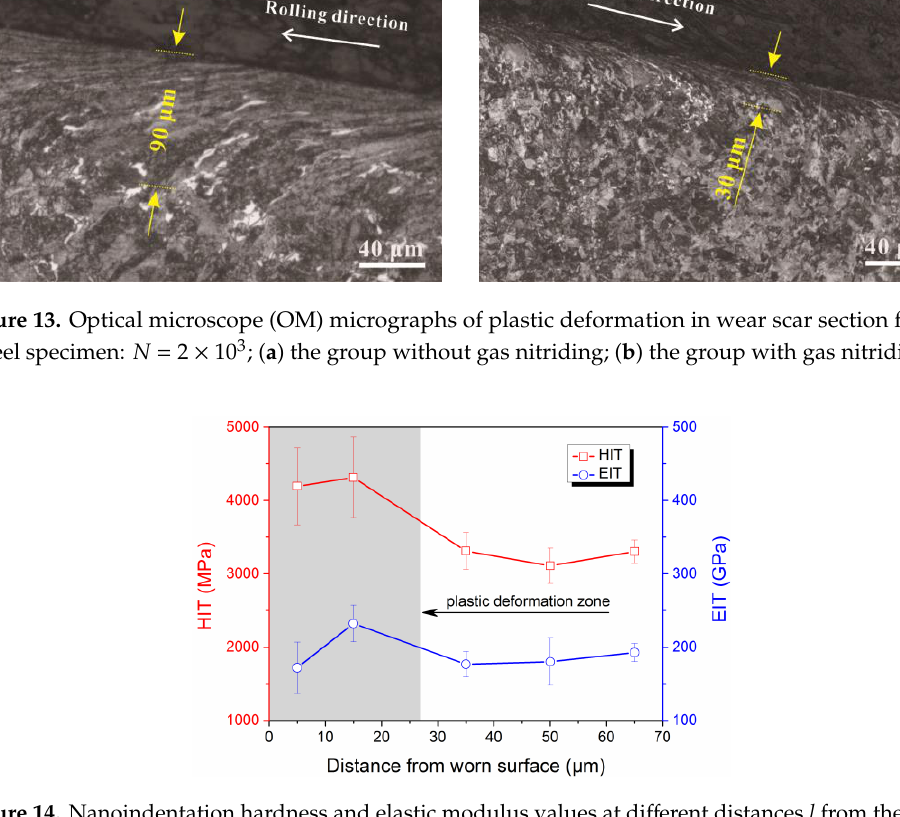
worn surface corresponding to the cross-section of Figure 13b. surface corresponding to the cross-section of Figure